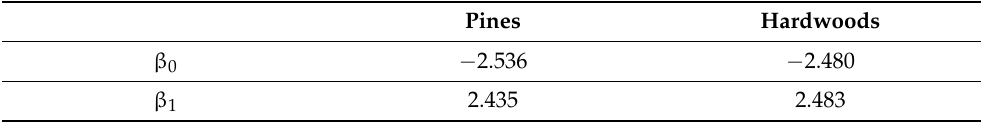
Table 3. Species-specific parameters for calculating